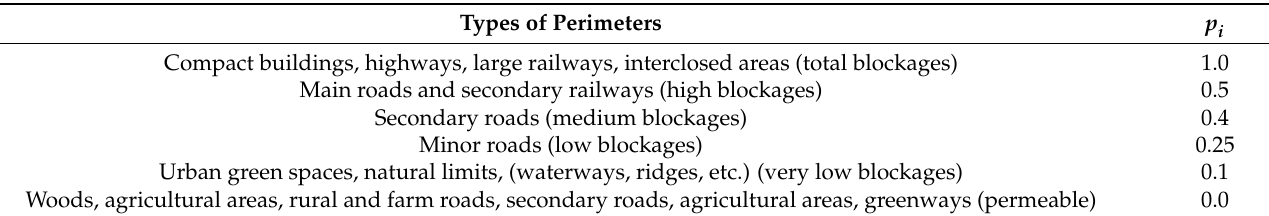
Table 1. Occlusion coefficients of